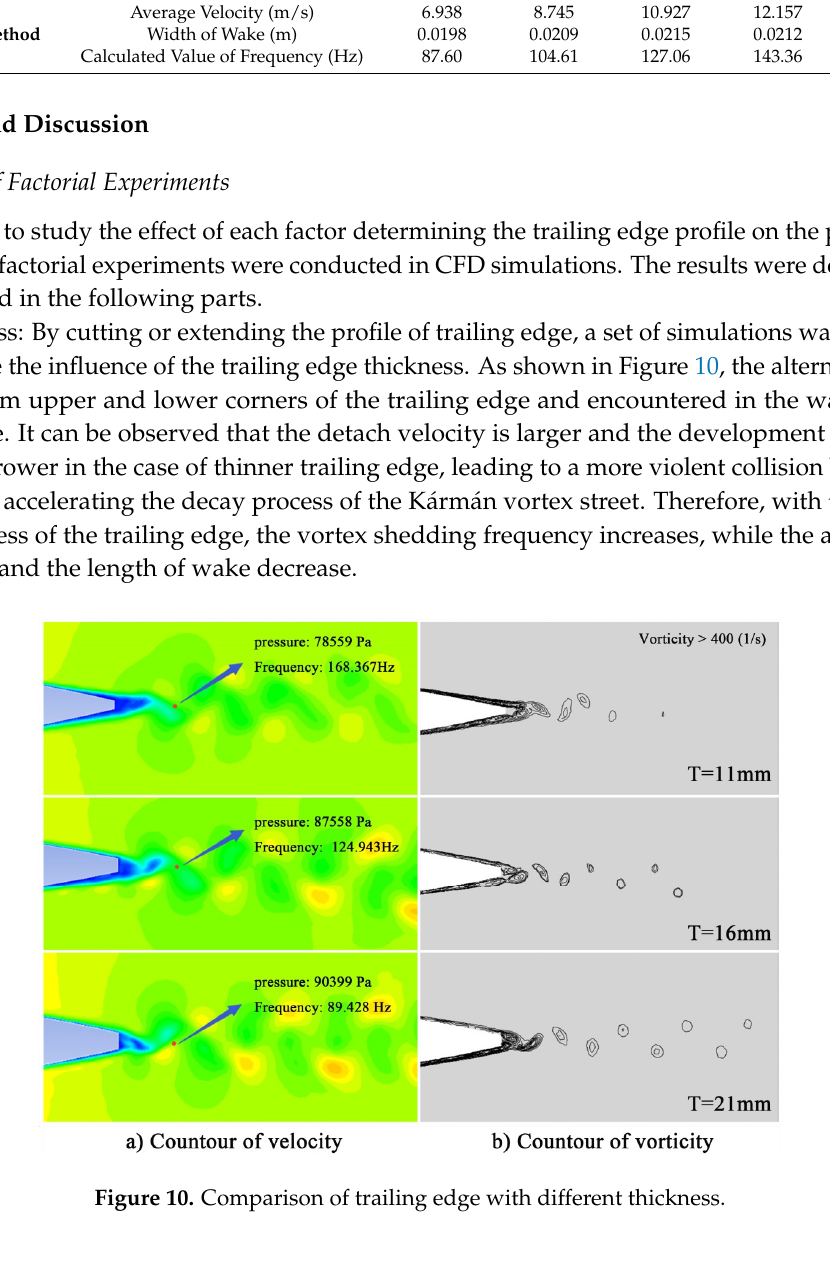
Table 4. Comparison of results obtained by different methods.